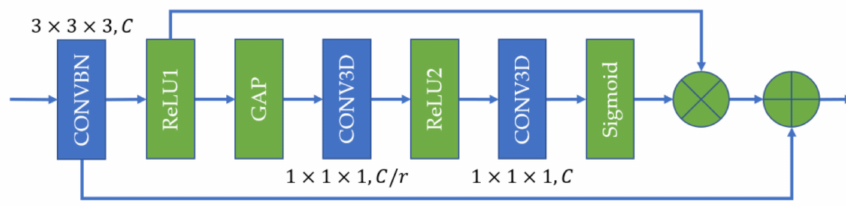
Figure 5. The structure of the residual channel-wise attention (RCA)